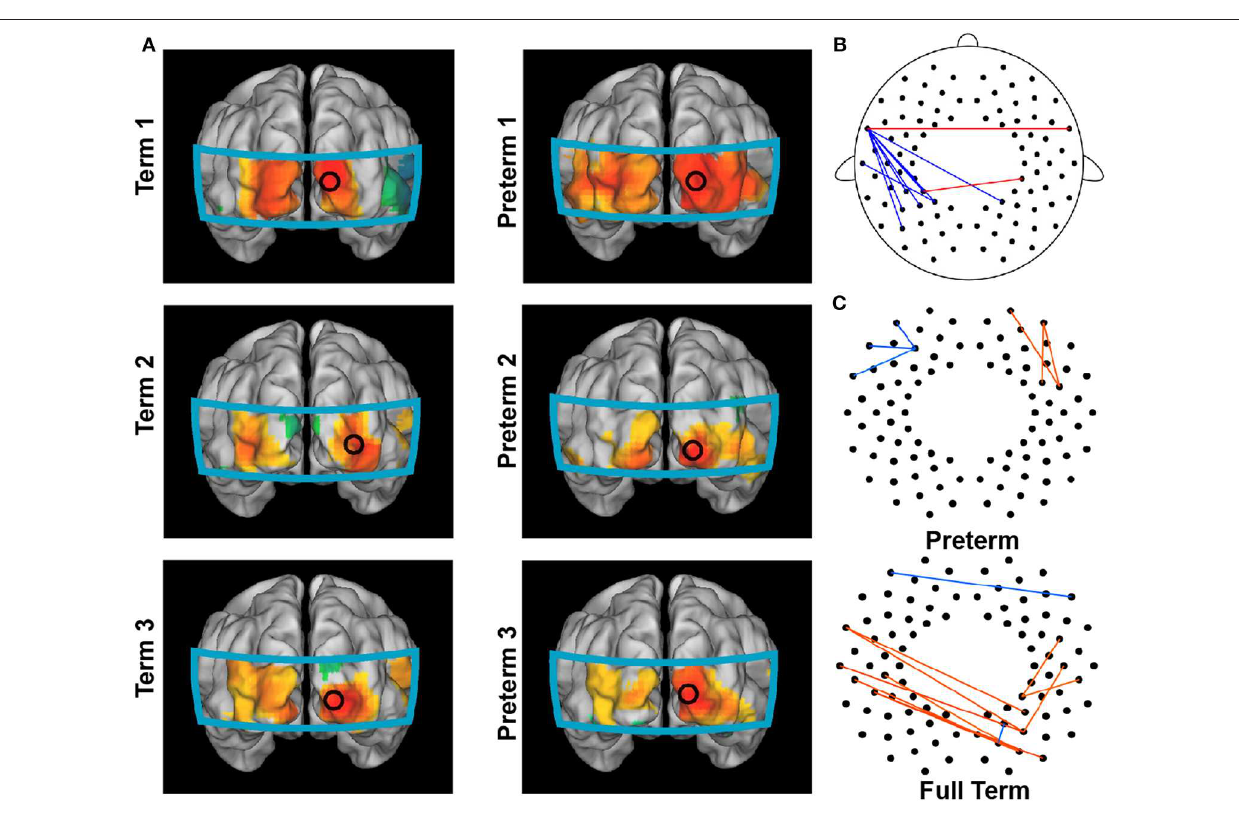
Frontiers in Neuroscience |